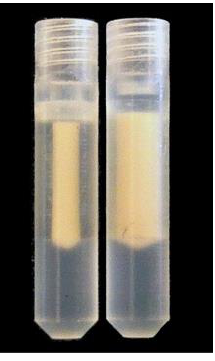
Figure 10. KcsA proteoliposomes in MAS rotor inserts post-experiment. Left: ‘floating’ sample in sucrose- augmented buffer, and Right: ‘sinking’ sample with no sucrose in buffer.